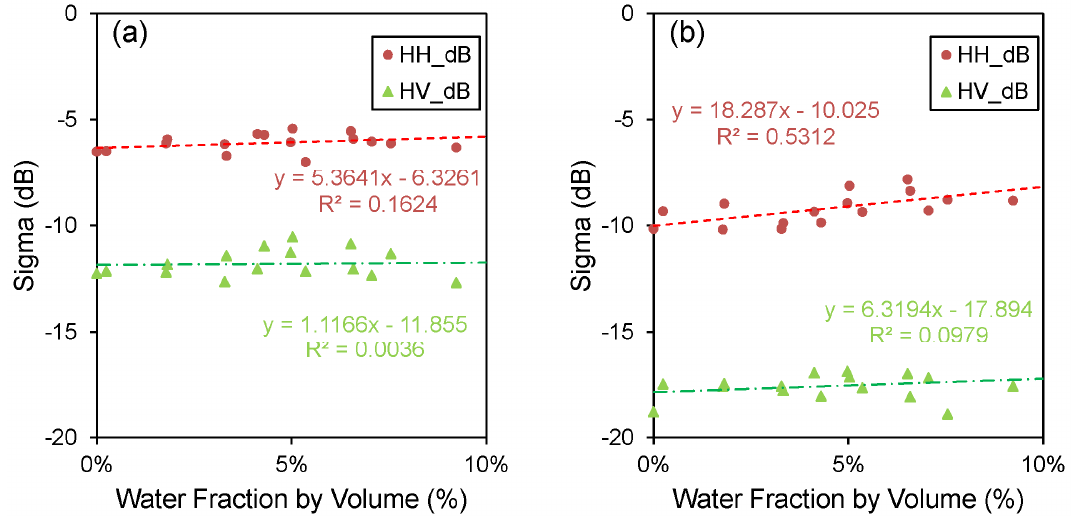
Figure 7. Mean backscatter (dB) plotted versus soil water fraction by volume (%). ( a ) high biomass band, and ( b ) low biomass